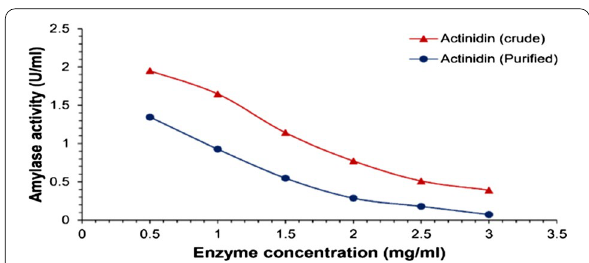
Fig. 3 α-amylase activity after 10 min of exposure to actinidin: control (water α-amylase) showed 2.43 U, filled square actinidin + (crude), and filled circle actinidin